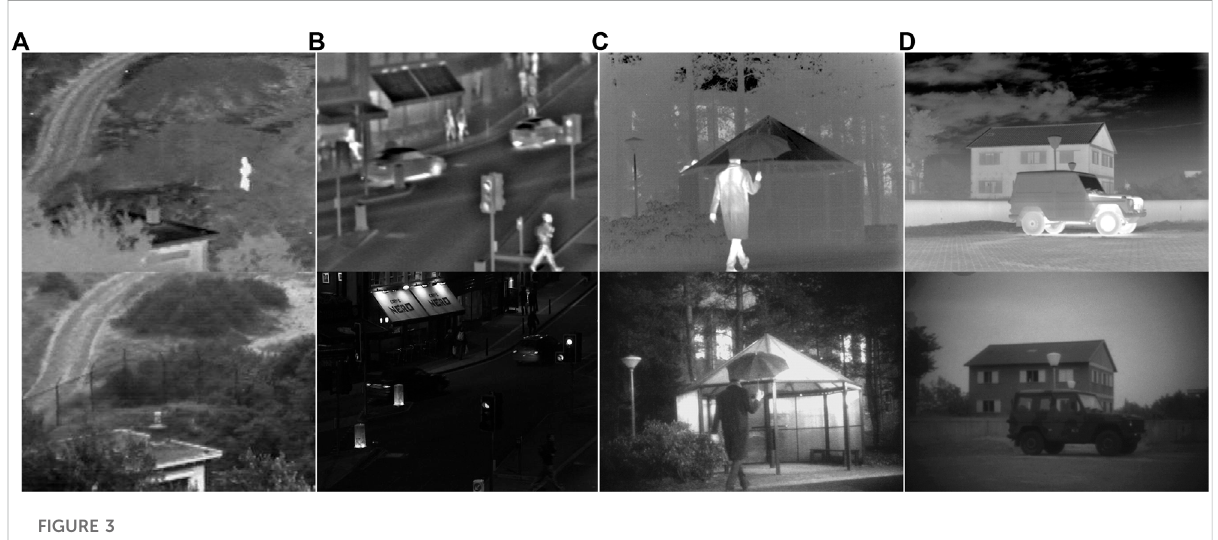
FIGURE 3 Four pairs of example